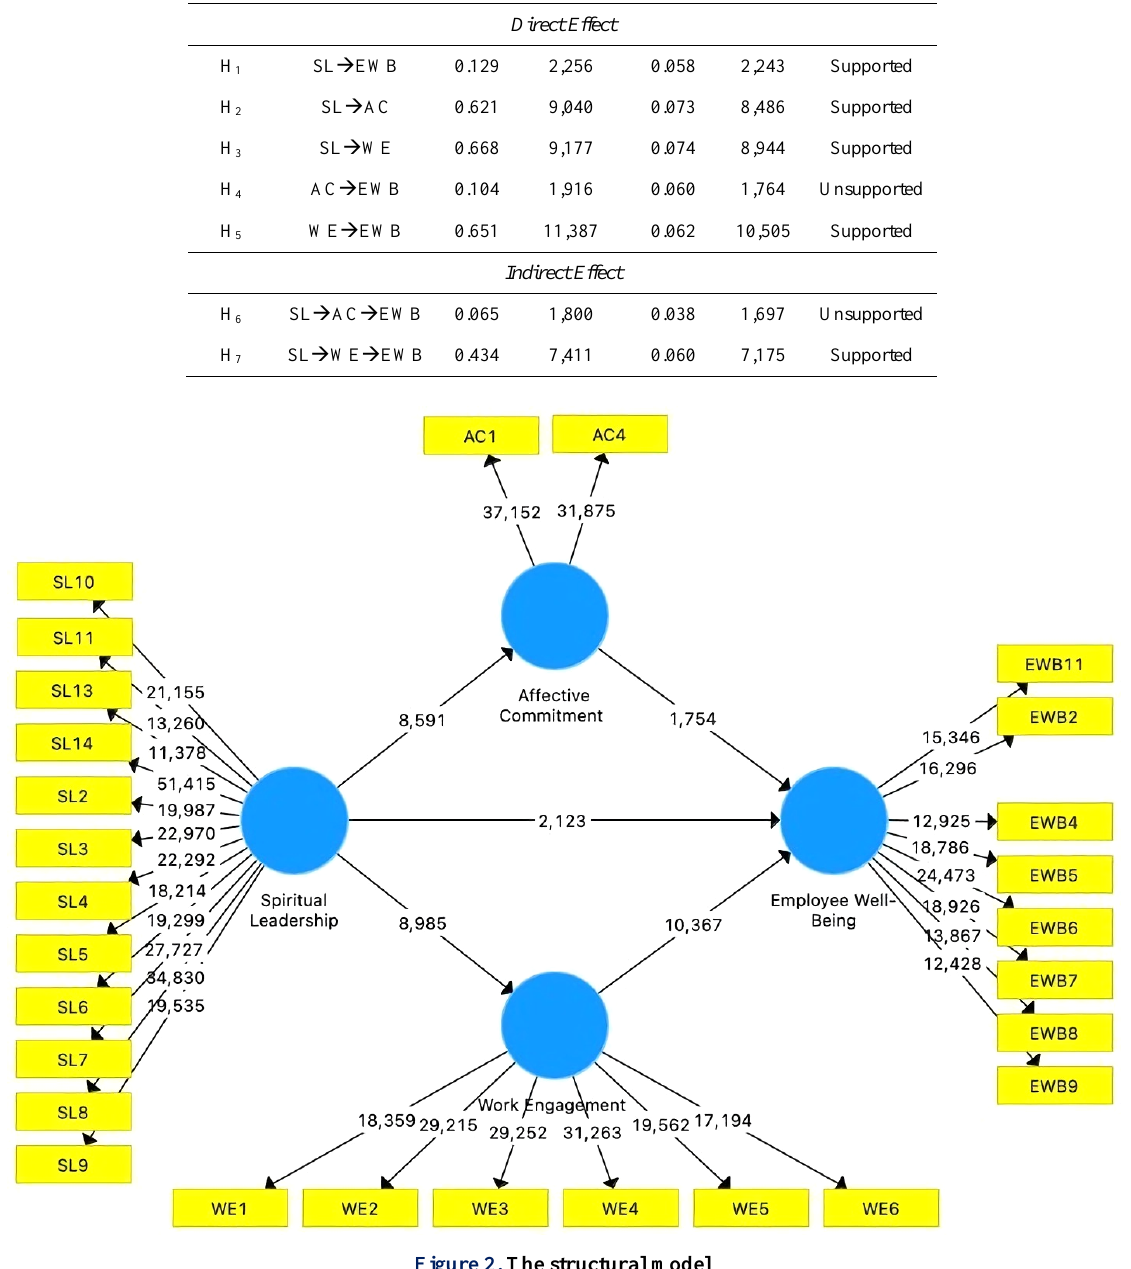
Figure 2. The structural